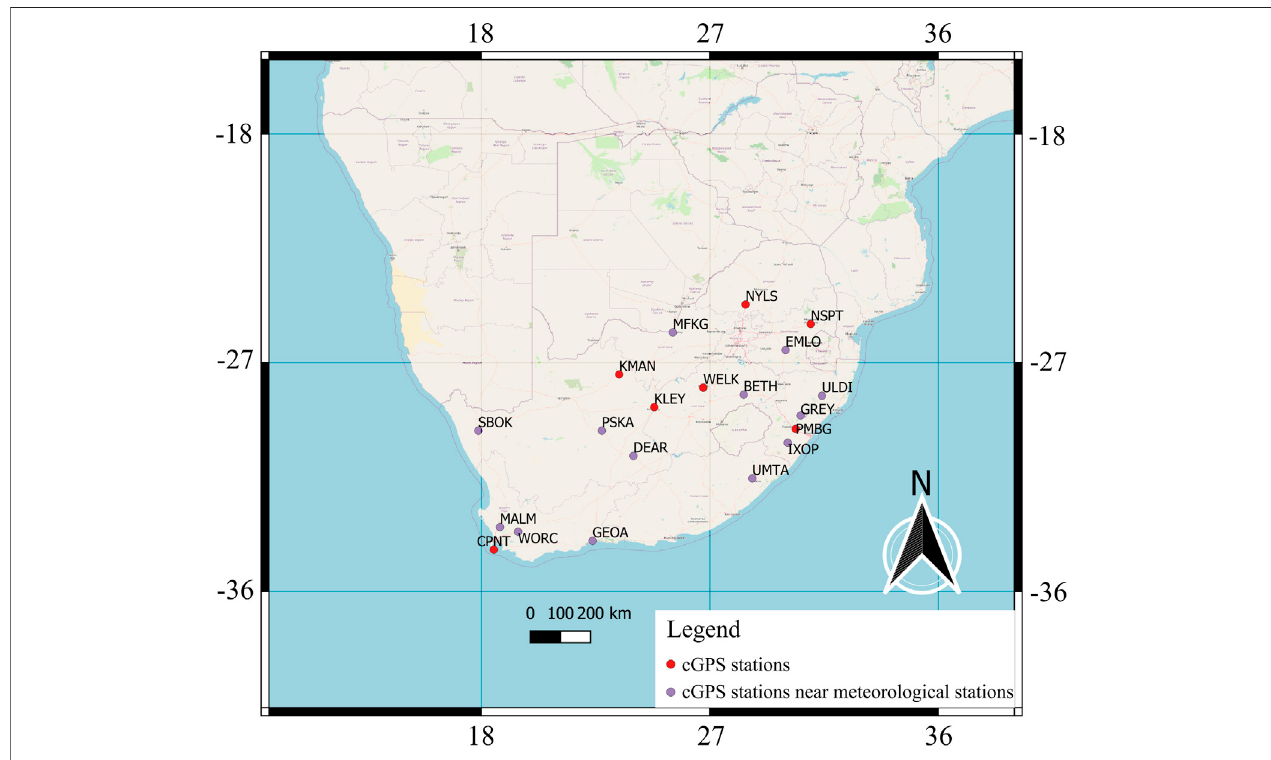
FIGURE 3 | Spatial distribution of the chosen cGPS and meteorological stations.